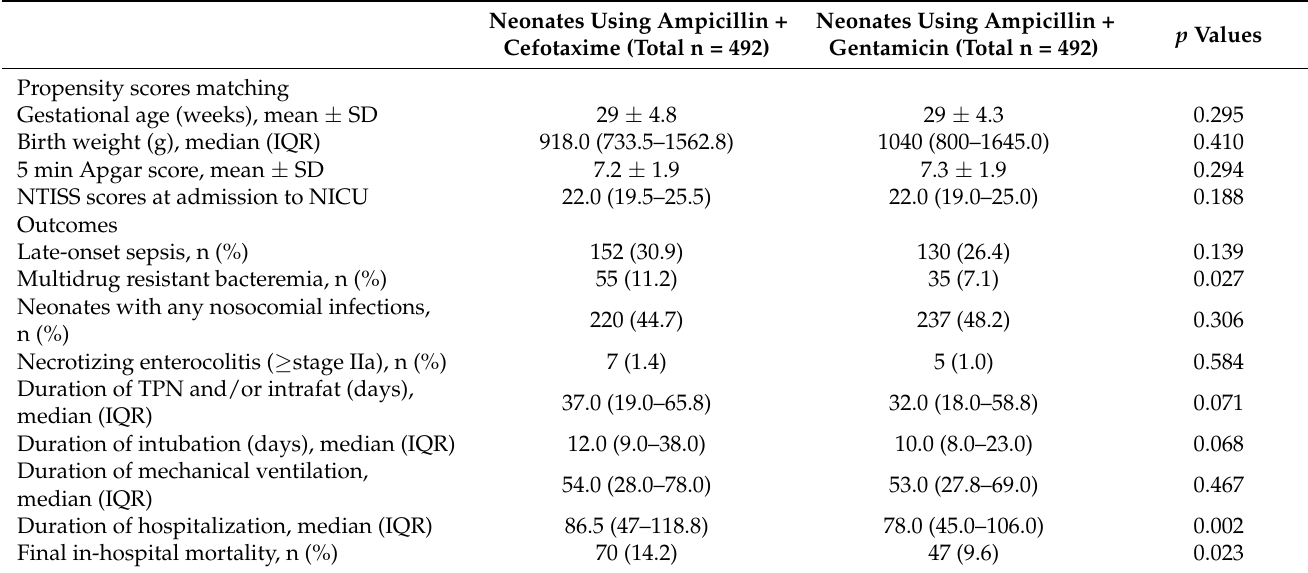
Table 3. Outcome comparisons of the two groups receiving different empiric antibiotics using the propensity score-matched analyses.